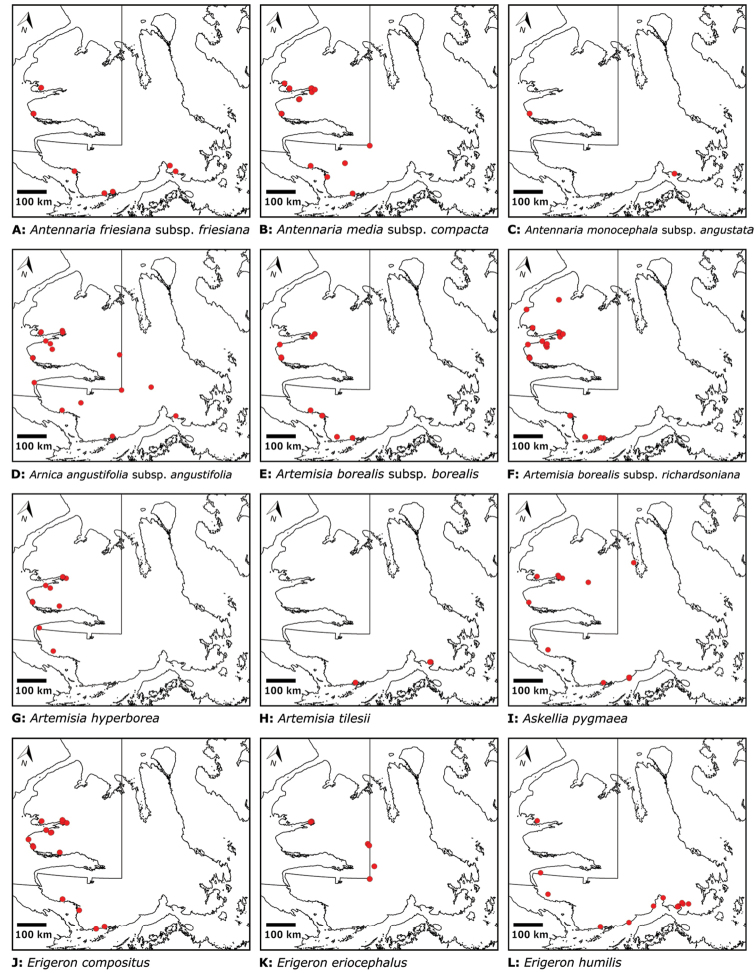
Species distribution maps. Asteraceae: AAntennaria
friesiana
subsp.
friesianaBAntennaria
media
subsp.
compactaCAntennaria
monocephala
subsp.
angustataDArnica
angustifolia
subsp.
angustifoliaEArtemisia
borealis
subsp.
borealisFArtemisia
borealis
subsp.
richardsonianaGArtemisia
hyperboreaHArtemisia
tilesiiIAskellia
pygmaeaJErigeron
compositusKErigeron
eriocephalusLErigeron
humilis.